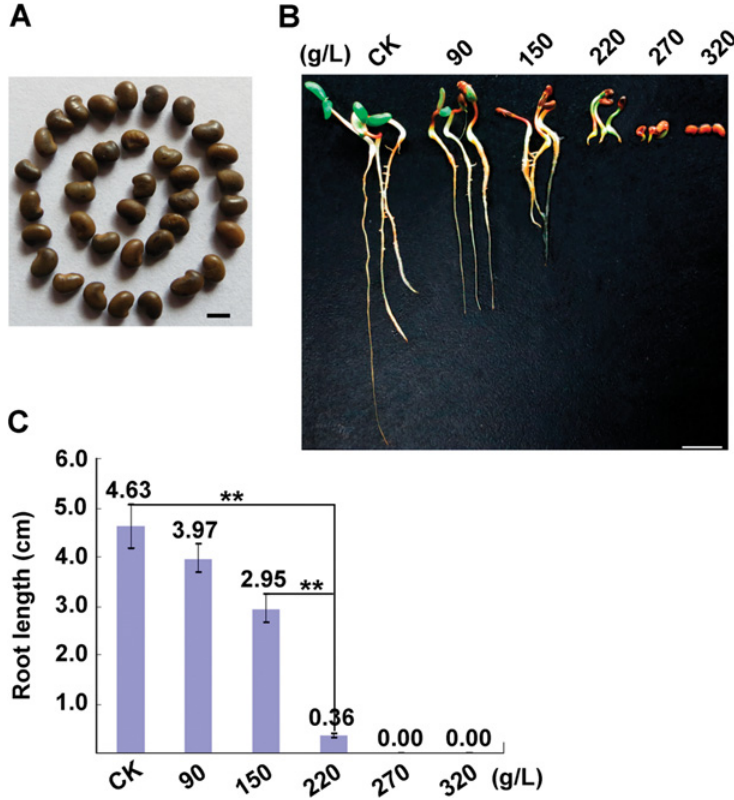
Fig 1. Effect of water stress induced by PEG-6000 on development of the Alhagi sparsifolia primary roots. (A) Seeds of A . sparsifolia (Scale bar = 2.0 cm). (B) Typical phenotype of the A . sparsifolia seedlings at 7 days post treatment with PEG-6000 (Scale bar = 1.0 cm). The A . sparsifolia seeds were first treated with concentrated sulfuric acid (98%) for 20 min, and then put on fully wetted filter paper at 25°C in the dark for 24 h. The germinated seeds were selected and transferred to petri dishes containing filter paper saturated with the different percentages of PEG-6000 solution (0, 90, 150, 220, 270 and 320 g/L), and were remained at 25°C in the dark for 3 days followed by 4 additional days but under 16-h light/8-h dark. At least 15 seedlings were included in each different treatment, and three independent experiments were preformed. (C) Average length of the primary roots of A . sparsifolia treated with PEG-6000 at 7 days. Error bars represent SE. P values determined by Student t test ( ** p <